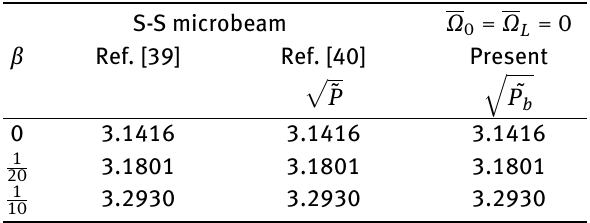
Table 1: Validation study for a simple supported microbar using strain gradient elasticity theory.